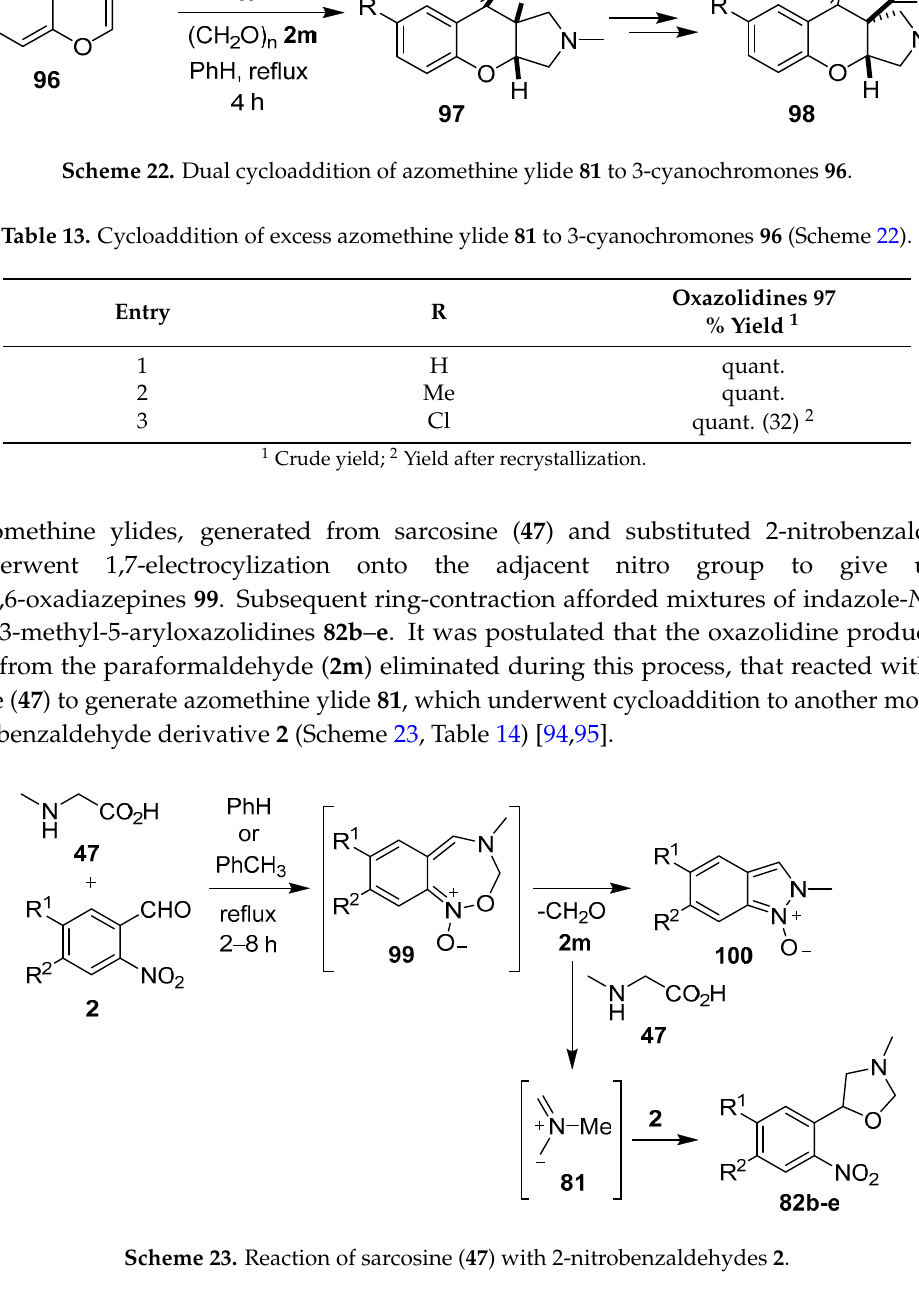
Table 14. Ring-contraction of benz-1,2,6-oxadiazepines 99 to indazole- N -oxides 100 and formation